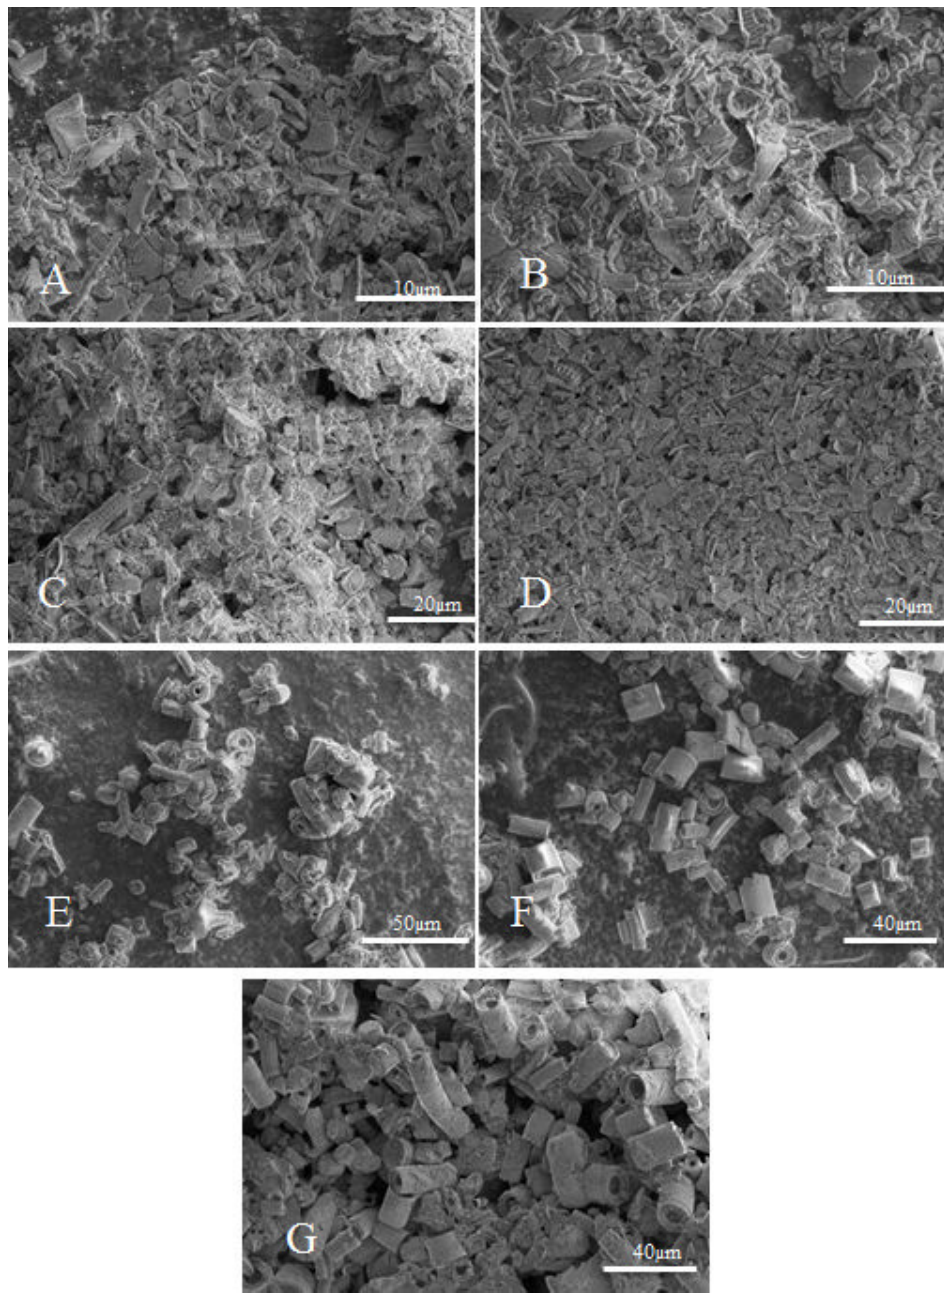
Figure 7. Microscopic images of fractionated diatomaceous earth ( A ) 0a, ( B ) 0b, ( C ) 1a, ( D ) 1b, ( E ) 2, ( F ) 3, ( G ) 4. The studied composites of epoxy resin Epidian 601 (epoxy number (mol/100g) 0.5–0.55, viscosity at 25 ◦ C (mPa · s) 800–1500), cross-linked with amine-based curing agent Z-1 (triethylenetetramine, viscosity at 25 ◦ C (mPa · s) 20–30; amine number (mg KOH/g) min 1100), contained different quantities (0, 12, 24, 36, 48, 60, 70% vol.) of base and fractionated diatoms with an average particle size distribution of approx. 10 µ m (Figure 8). The choice of the resin/hardener system was dictated, on the one hand, by the necessity to obtain a low viscosity of the mixture, and on the other hand, by the optimal time of its final